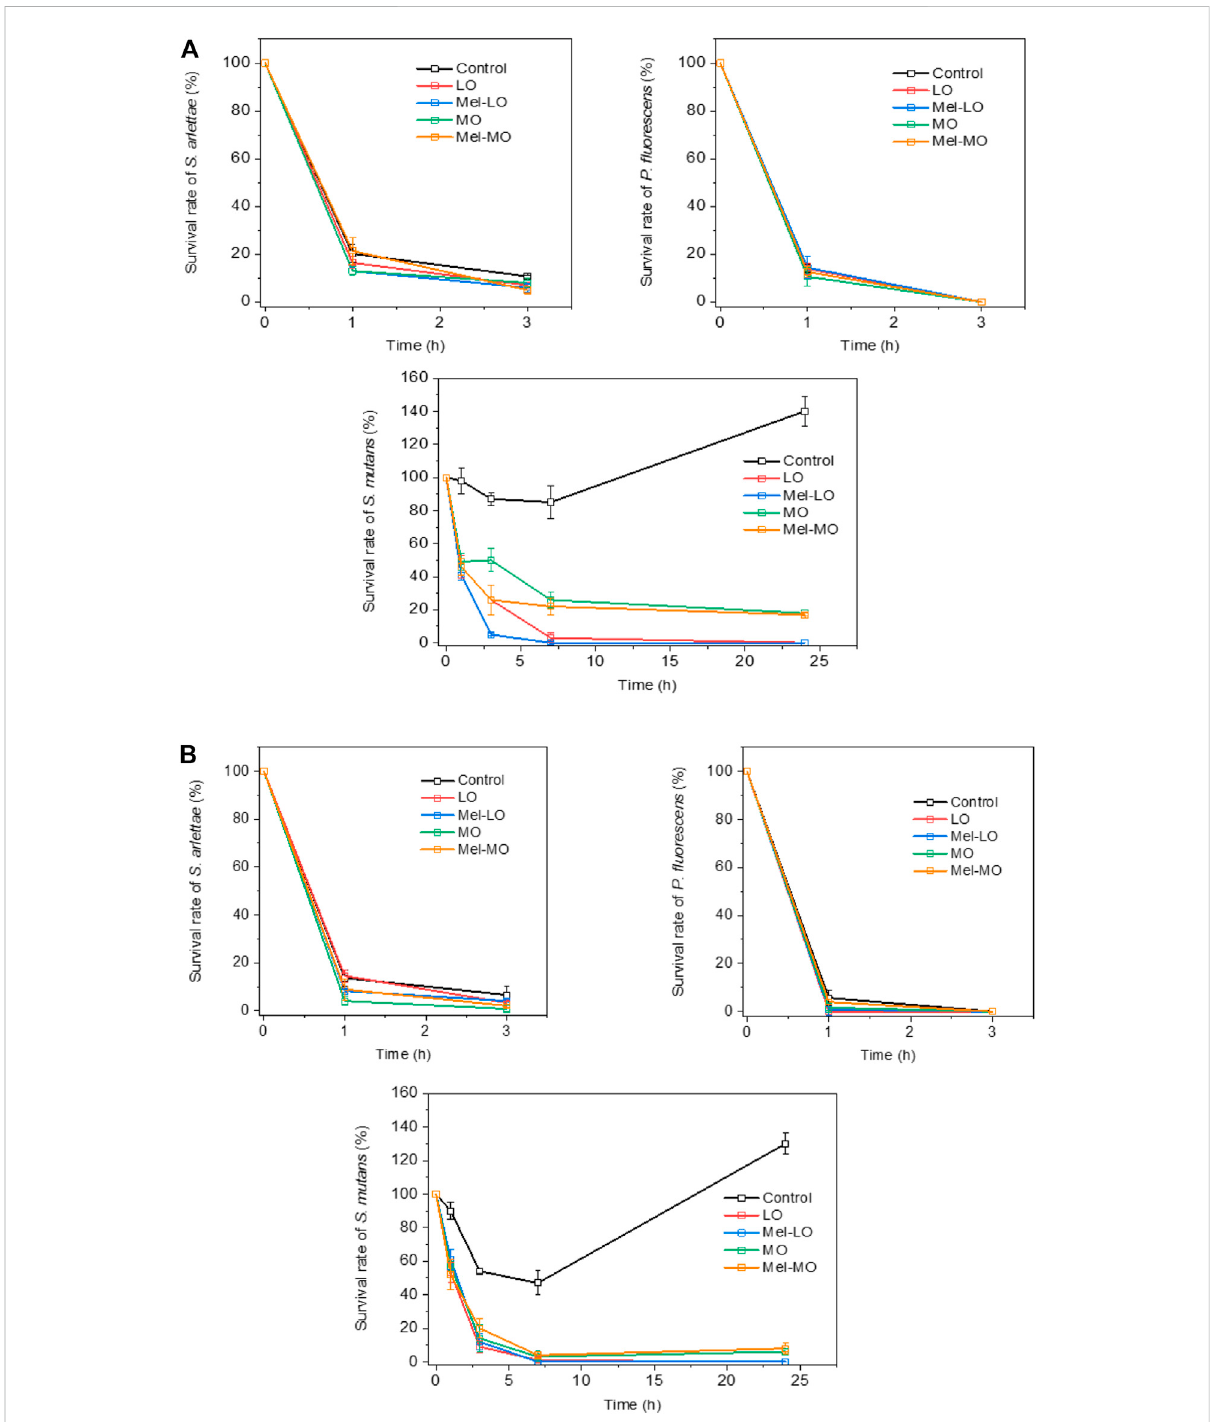
FIGURE 5 (A,B) . Survival rate of tested bacteria over time on (A) radial-longitudinal and (B) tangential-longitudinal wood